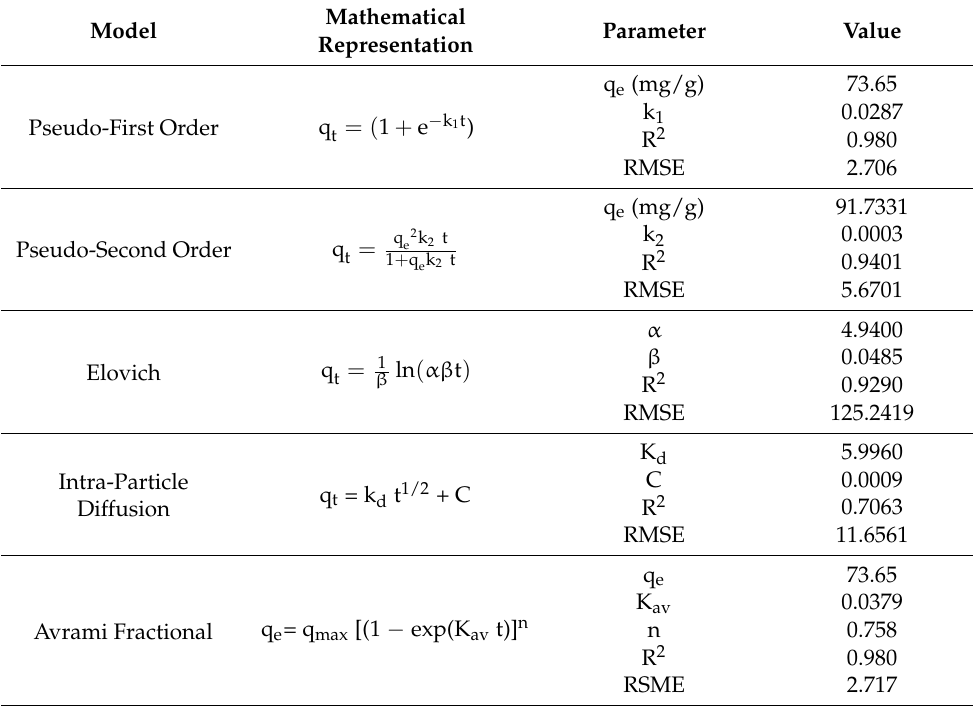
Figure 6. Plots for experimental data vs. predictions for non-linear equilibrium models for SBAC- MgAlFe phenol uptake.